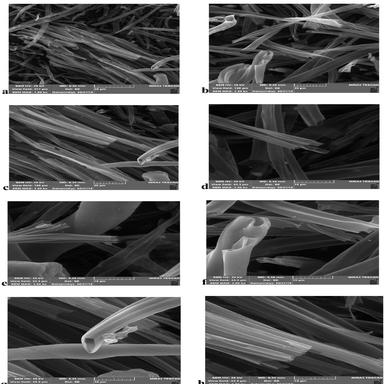
Scanning electron microscopy (SEM) micrographs of the bio-char sample carbonized at 850 °C. The SEM images with different magnifications: a) 1000×, b) 2000 × and c) 2000×, d-h) 5000 × .